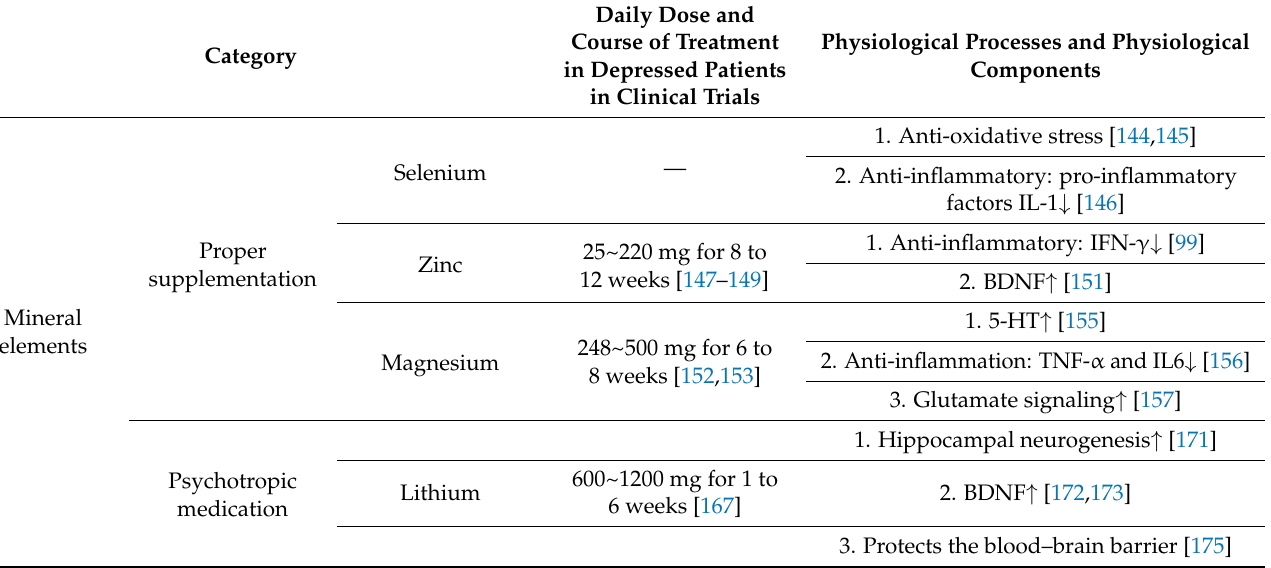
Table 2. A summary of the benefits of proper supplementation with some mineral elements or as medication that can help improve